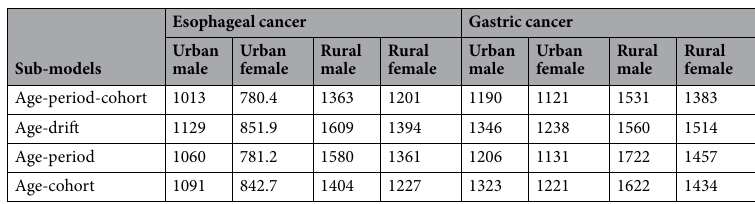
Table 1. Akaike information criterion (AIC) of age-period-cohort sub-models for upper gastrointestinal cancer mortality, China,